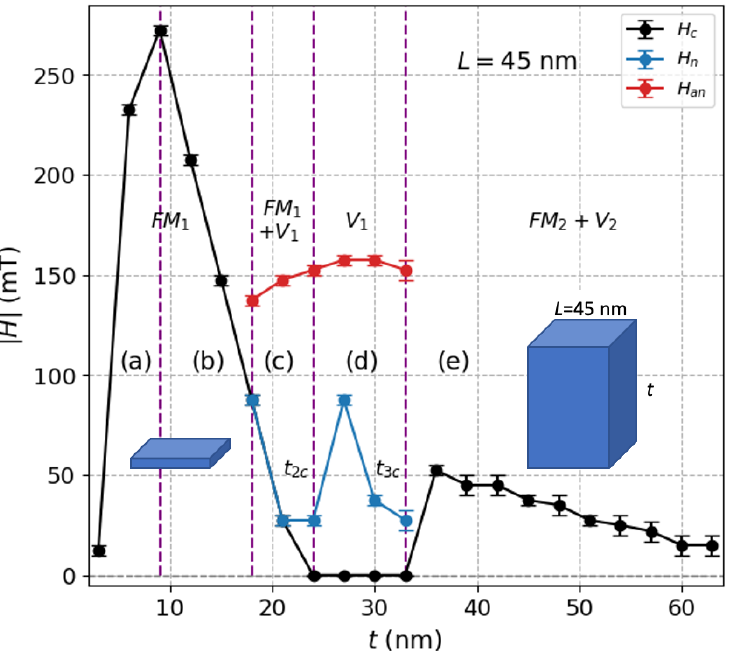
Figure 5. Thickness dependence of the absolute value of coercivity ( H c ), nucleation field ( H n ) and annihilation field ( H an ) of V 1 -states for prisms with L = 45 nm. A non-zero coercivity new phase (FM 2 + V 2 ) is observed beyond a critical thickness t 3 c